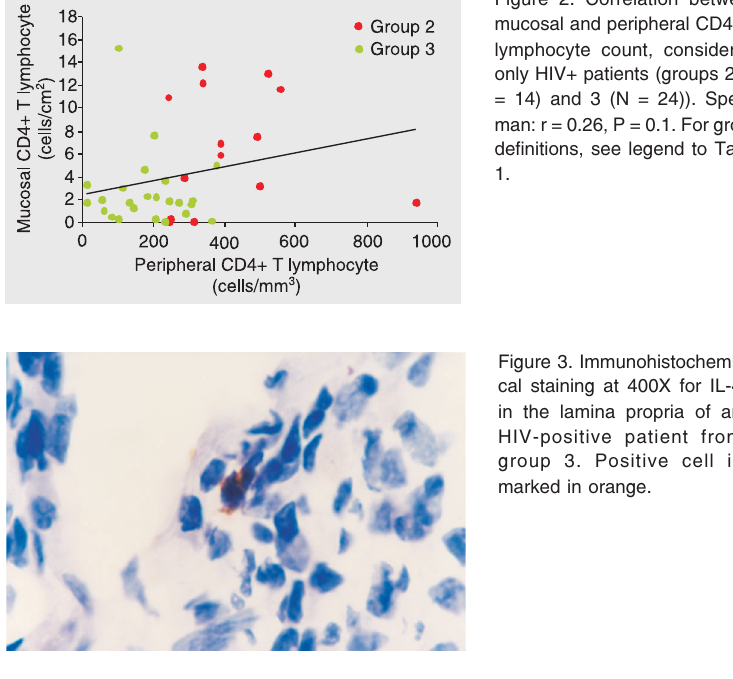
Figure 2. Correlation between mucosal and peripheral CD4+ T lymphocyte count, considering only HIV+ patients (groups 2 (N = 14) and 3 (N = 24)). Spear- man: r = 0.26, P = 0.1. For group definitions, see legend to Table 1.